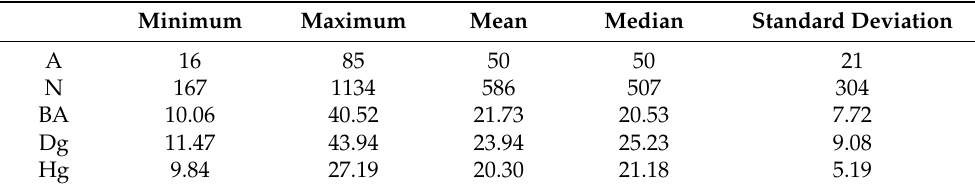
Table 1. Summary characteristics of the black locust sample plots located in West Poland: average stand age (A, years), stocking (N, trees ha − 1 ), basal area (BA, m 2 ha − 1 ), average diameter at breast height (Dg, cm), and average height (Hg, m).